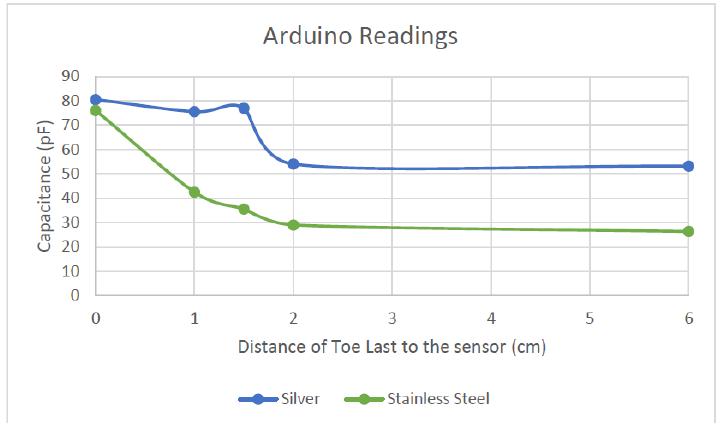
Figure 24. Capacitance readings using Arduino, comparing silver and 80/20 polyester/stainless steel knitted samples.